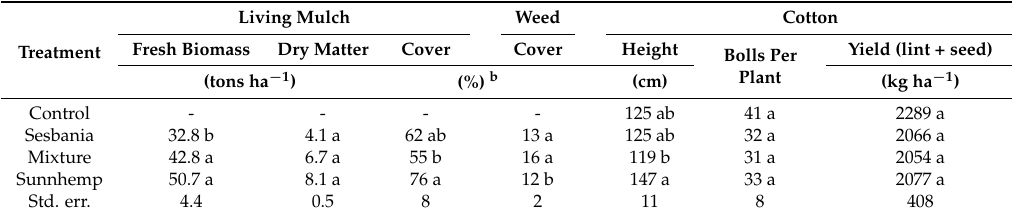
Table 7. Least squares means of cotton, living mulch and weed parameters from mixture treatment data pooled across Sites 2 and 4 during Year 2 a .